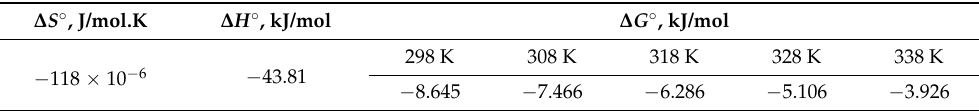
Table 3. Thermodynamic analysis of U(VI) ion extraction by HTIP chelating ligand.